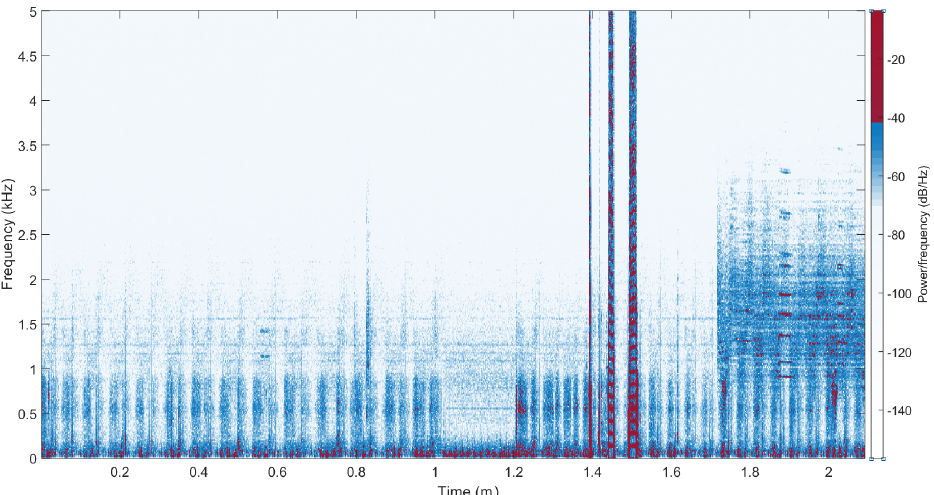
Figure 5. The spectrogram for one